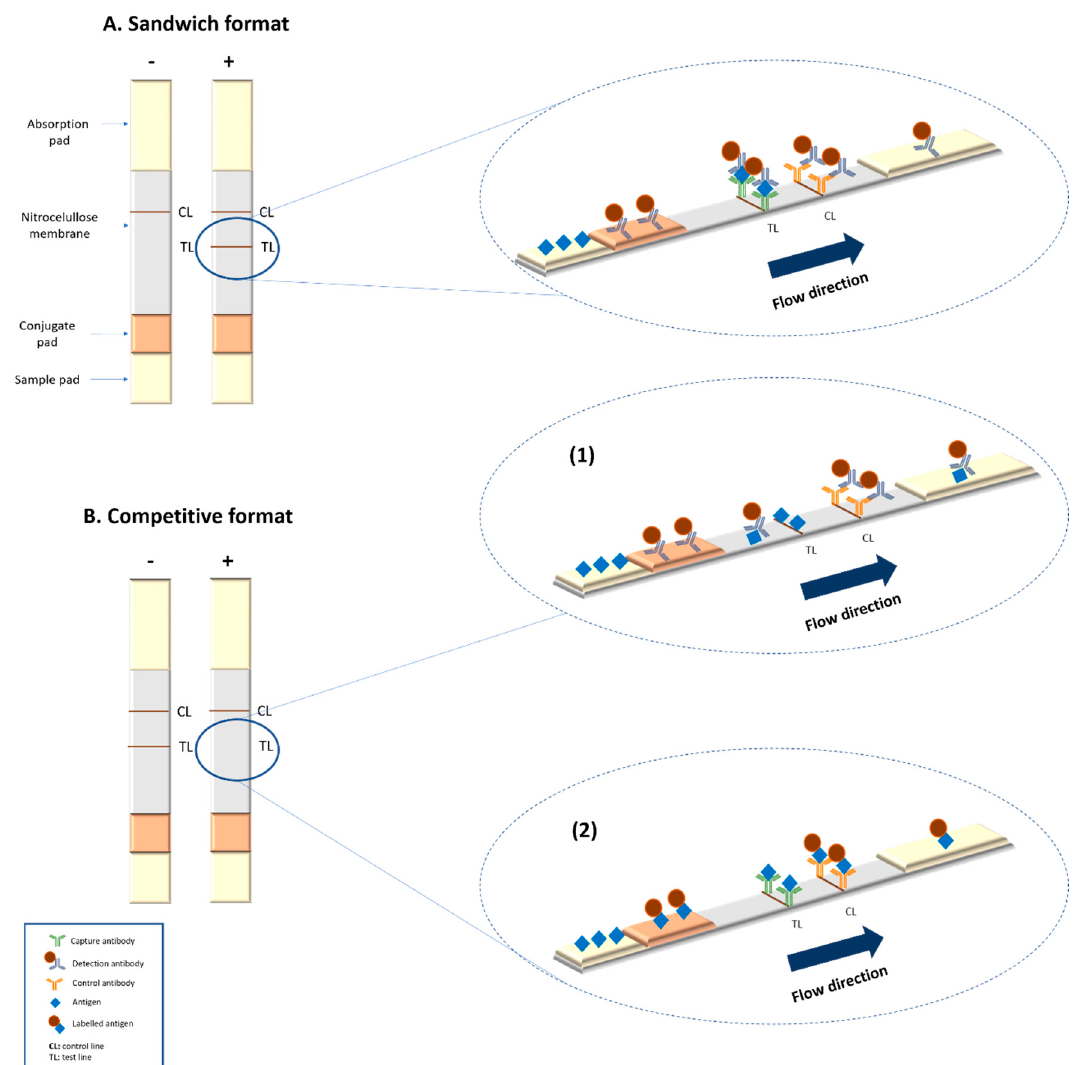
Figure 1. Summary of the basic formats of lateral flow assays. ( A ) Scheme of a sandwich format lateral flow immunoassays (LFIA). ( B ) Scheme of a competitive format LFIA: (1) when antigen is immobilized at the test line and labelled antibody is used as detection system; (2) when antibody is immobilized at the test line and labelled antigen is used for detection.